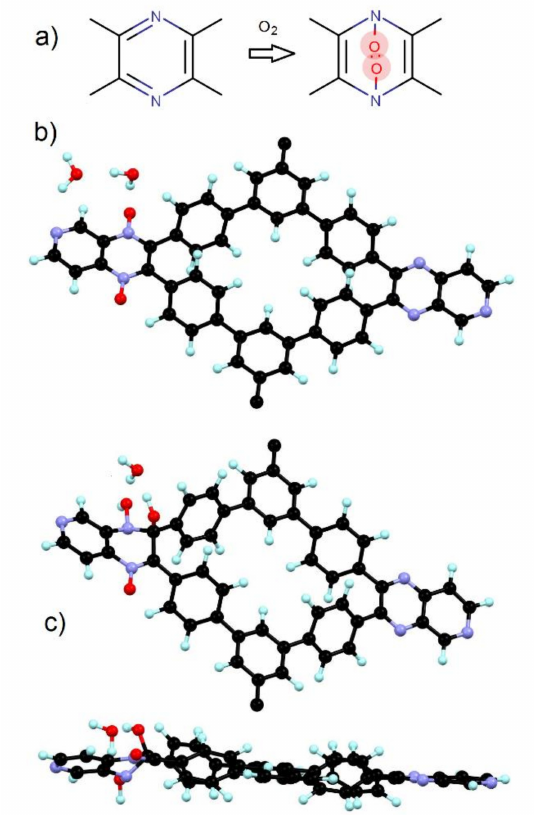
Figure 7. The scheme of bond reconstruction during activation of oxygen molecule on CPP-2 ( a ) and optimized atomic structures of the part of CPP-P2 in the first ( b ) and second ( c ) steps of the